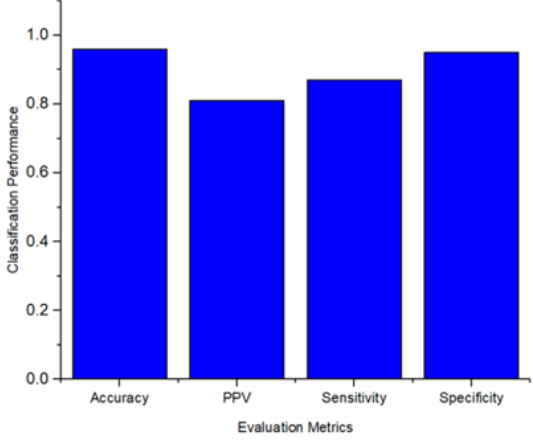
Figure 10. Microaneurysms sign classification performance.